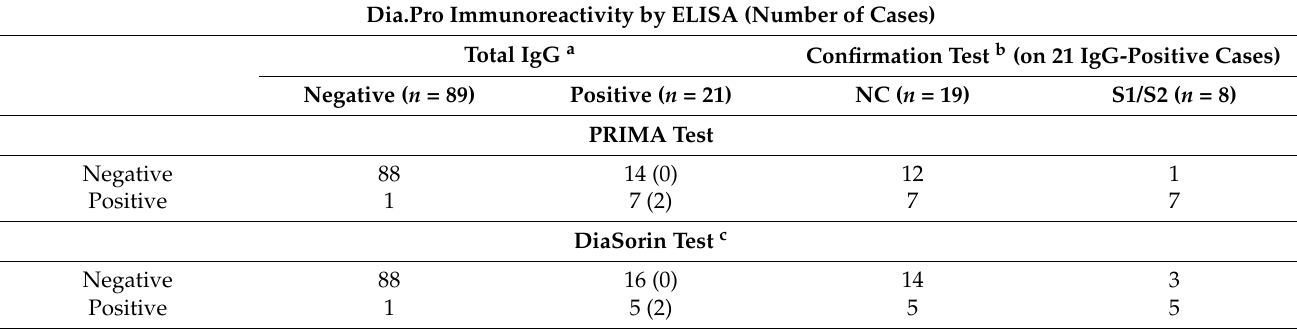
Table 1. Performance at T 0 of the Dia.Pro immunoassay (total IgG and confirmation test) compared to alternative approaches. Dia.Pro Immunoreactivity by ELISA (Number of Cases) Total IgG a Confirmation Test b (on 21 IgG-Positive